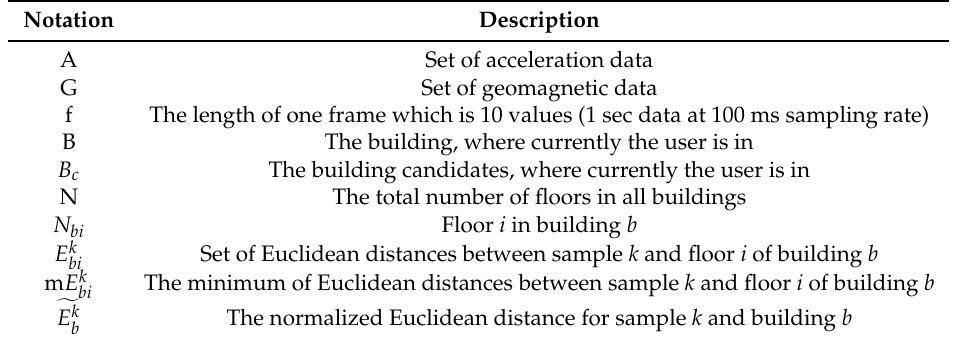
Table 1. Notations used in Algorithm 1.